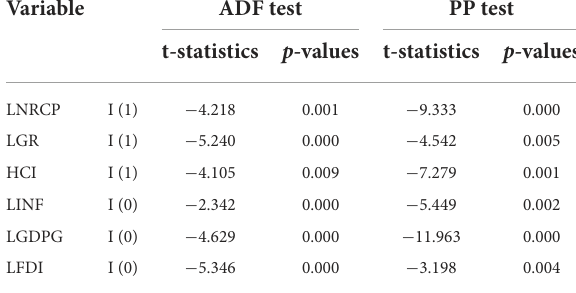
TABLE 3 Variance inflation factor.